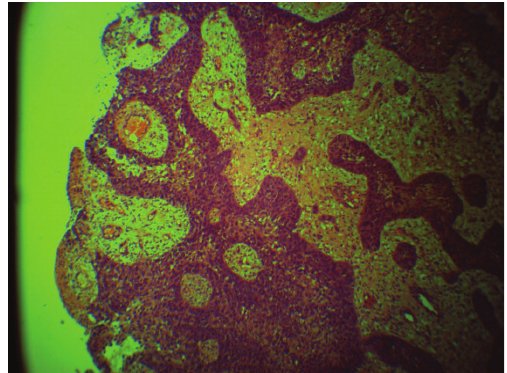
Figure 2: Photomicrograph of the breast lesion ( × 100). Section shows sheets and cords of malignant squamous epithelial cells invading the fibrocollagenous stroma. These sheets are of variable sizes and show focal areas of necrosis as well as granulation tissue formation. The stroma shows extensive desmoplasia with moderate infiltration by acute and chronic inflammatory cells. No keratin pearl is seen.